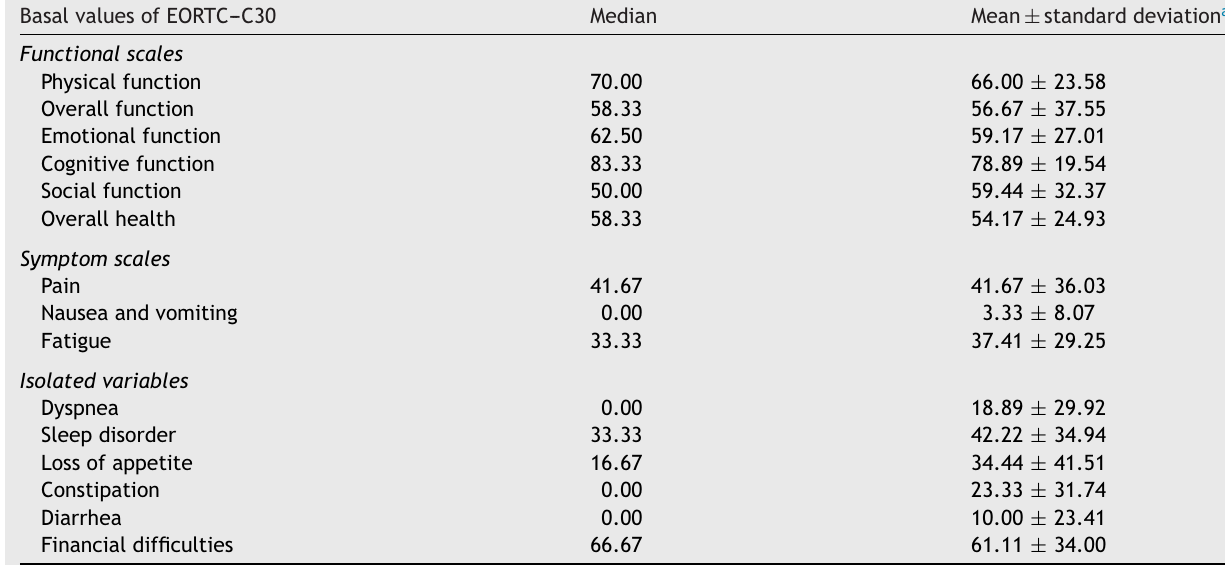
Table 2 Basal values of EORTC---C30 questionnaire for patients. Basal values of EORTC---C30